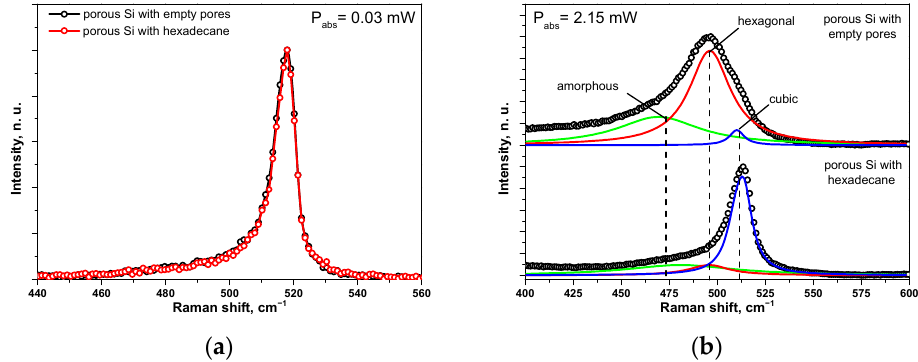
Figure 5. Raman peaks of a porous Si layer of about 80% porosity with empty pores, and pores filled with hexadecane at low and high absorbed laser powers: ( a ) 0.03 mW and ( b ) 2.15 mW.